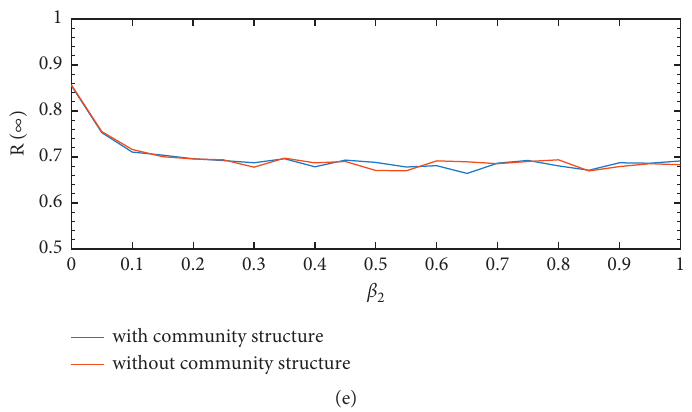
Figure 6: The influence of information transmission rate on the coupled disease-awareness model. (a) Density of infected individuals in the physical layer as a function of time. (b) Density of recovered individuals in the physical layer as a function of time. (c) Density of aware individuals in the virtual layer as a function of time. (d) Density of recovered individuals in the virtual layer as a function of time. (e) The final density of recovered individuals in the physical layer under different information transmission rates for the virtual contact networks with or without community